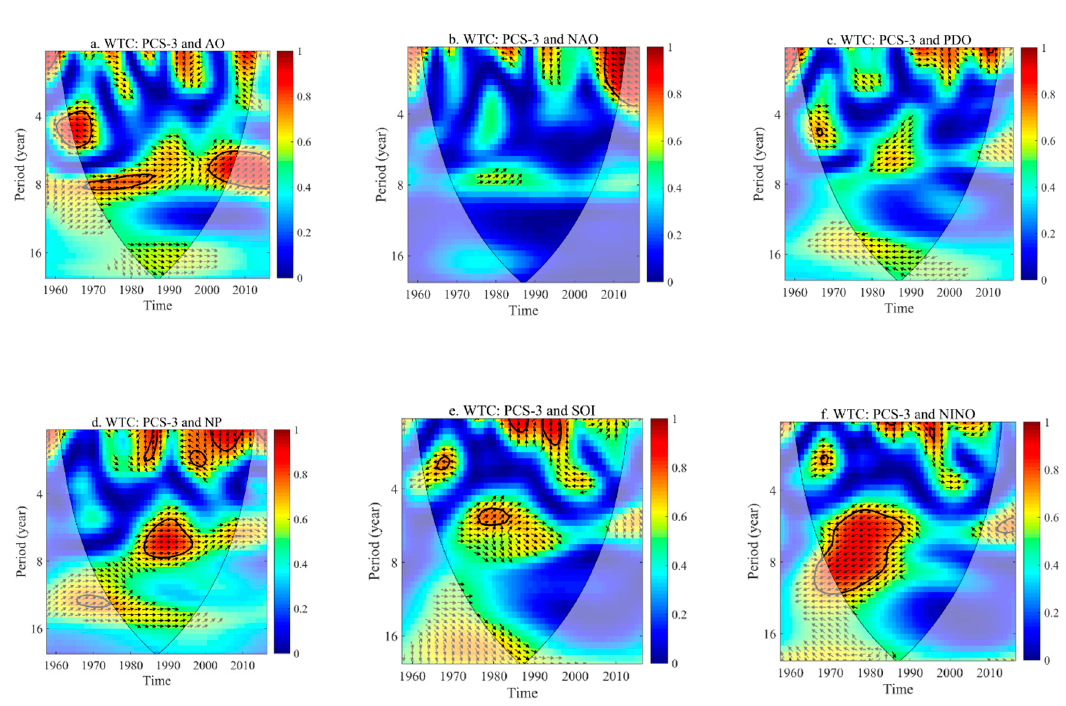
Figure 8. Wavelet coherence spectrum between PCS-2 and climate oscillations ( a – f climate oscillations of AO, NAO, PDO, NP, SOI and NINO, respectively).